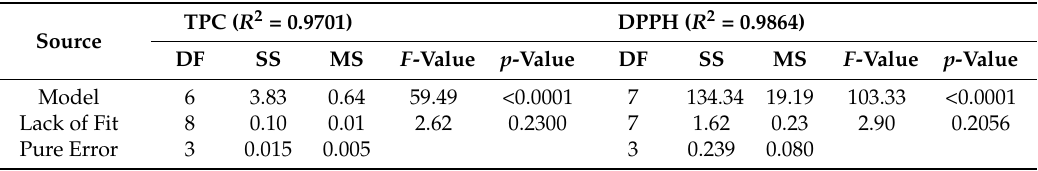
Table 4. Analysis of variance (ANOVA) for the fitted quadratic polynomial model for optimization of extraction parameters.